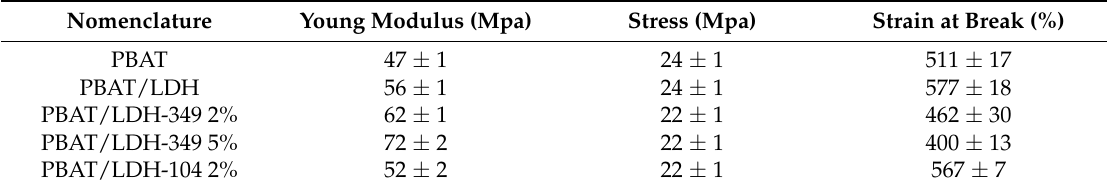
Table 1. Mechanical performances of neat poly(butylene adipate-co-terephthalate) (PBAT) and the resulting nanocomposites.